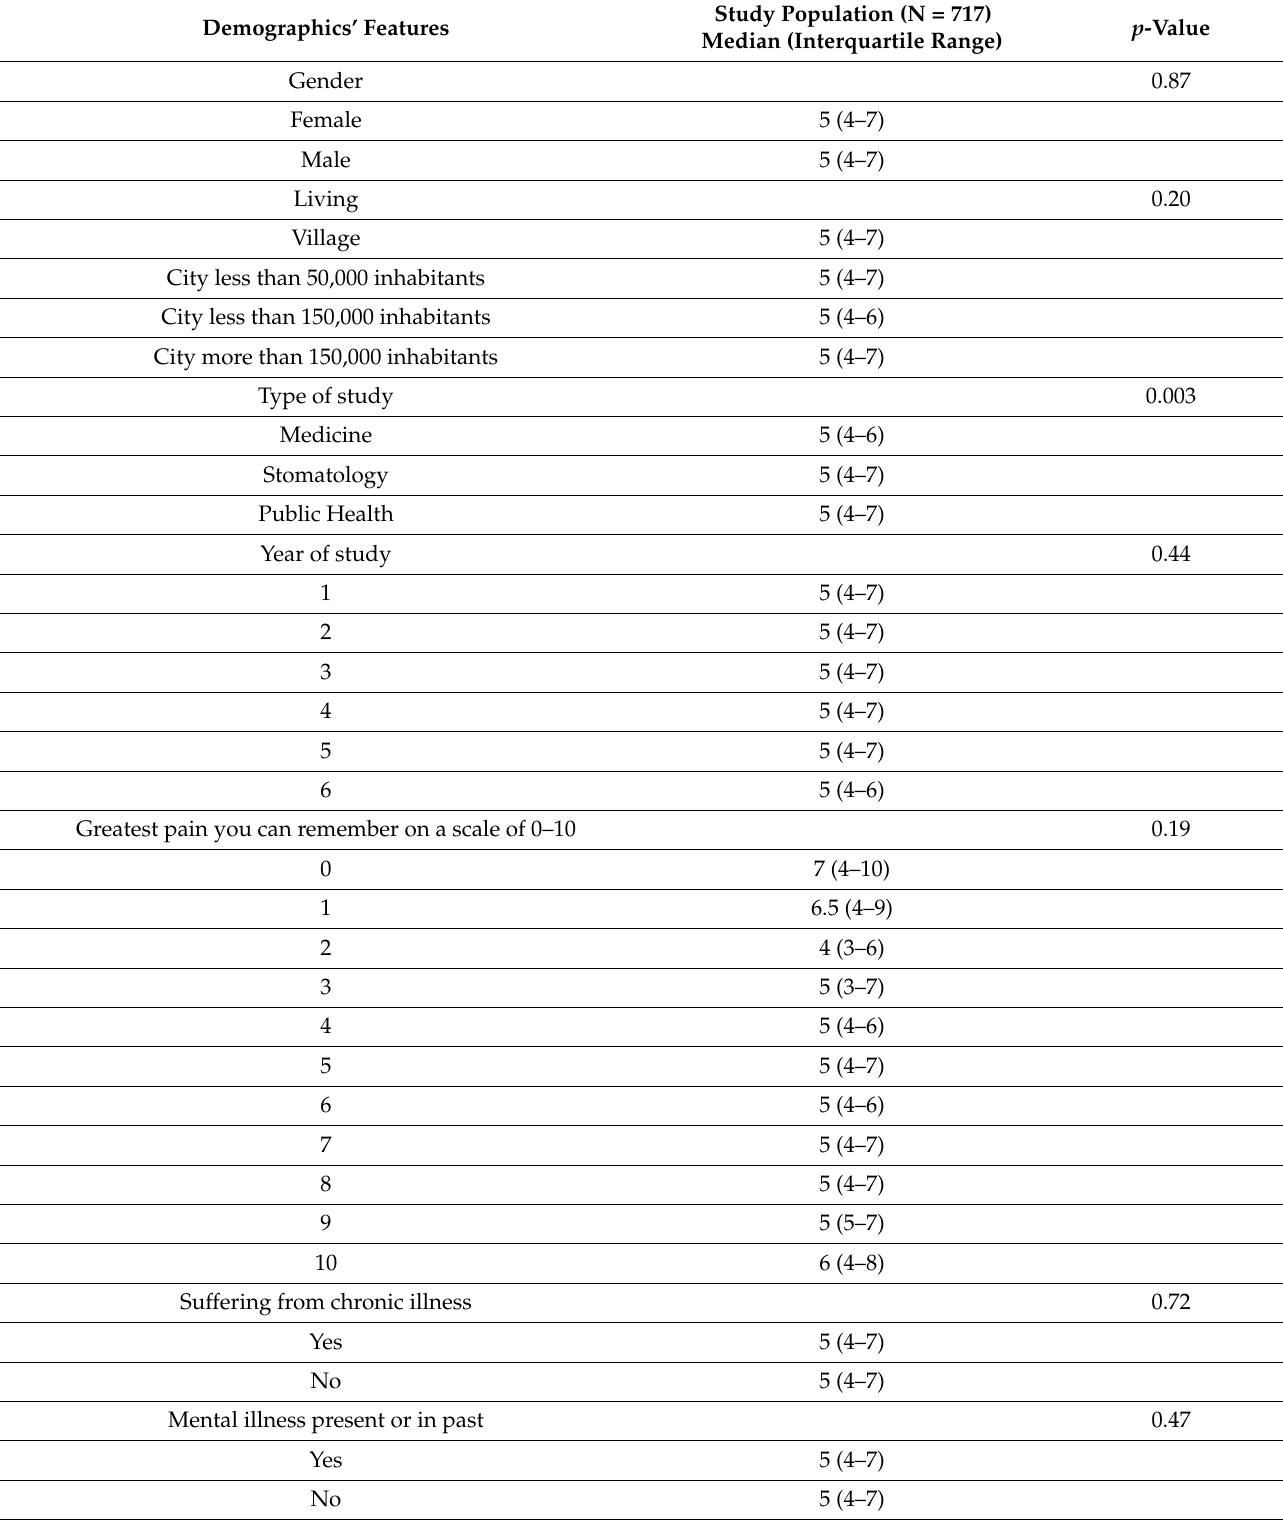
Table 2. Factors associated with fear of minor